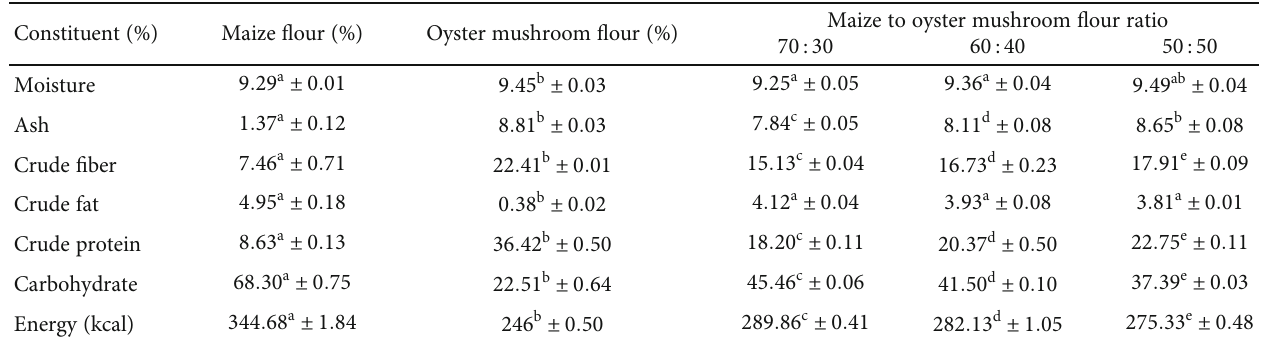
Maize to oyster mushroom fl our